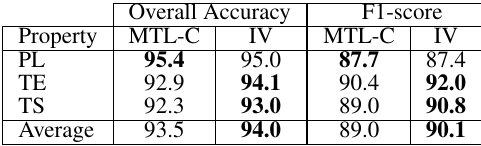
Table 4. Comparison of (mean) overall accuracies [%] and (mean) F1-scores [%] between our approach and the approach presented in (Dorozynski et al., 2019).